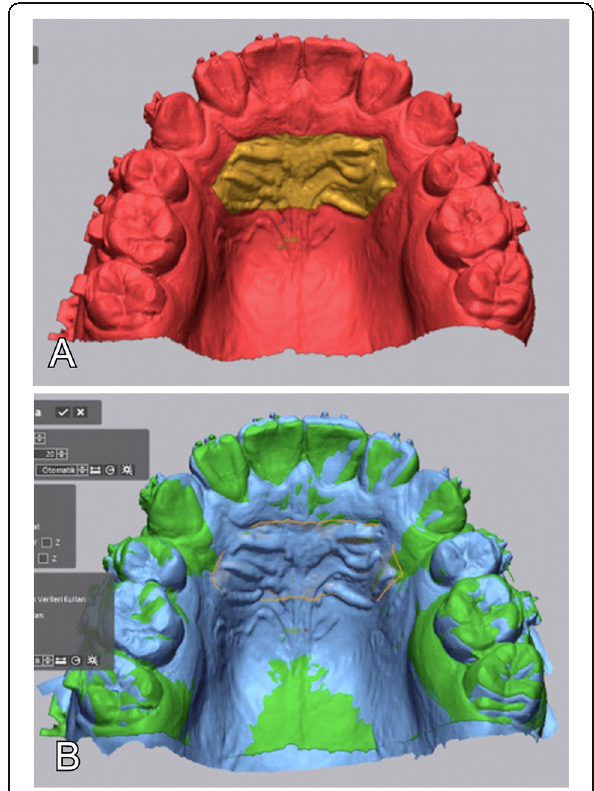
Fig. 3 A Reference area selection. B Local best-fit